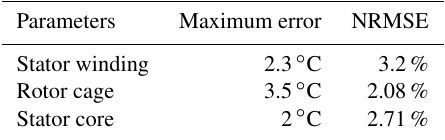
Figure 19. Comparison of measured and estimated temperatures under